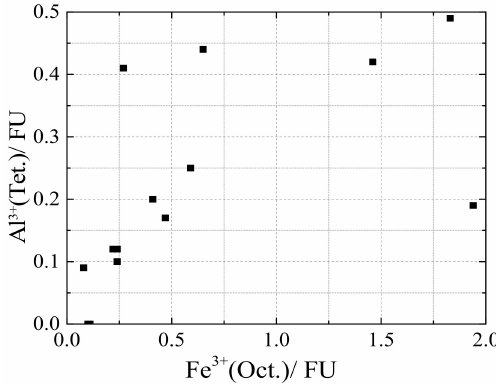
Figure 13. Relationship between tetrahedral Al 3 + content and octahedral Fe 3 +